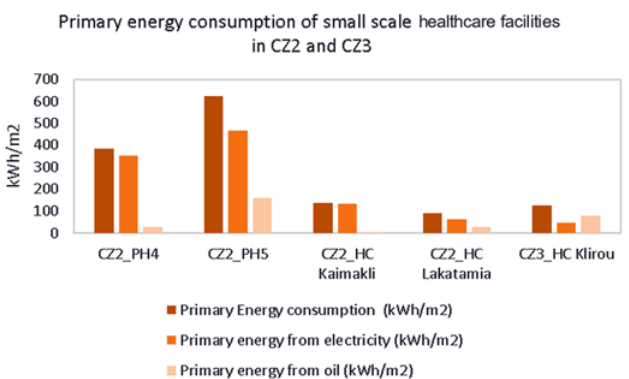
Fig. 5. Primary energy consumption of small-scale healthcare facilities.